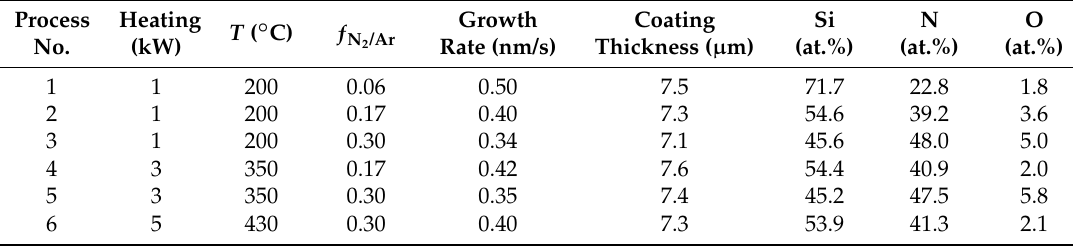
Table 1. Heating power, resulting substrate temperature, nitrogen-to-argon flow ratio ( ƒ N rate and thickness as well as resulting composition (as determined by XPS) for the different